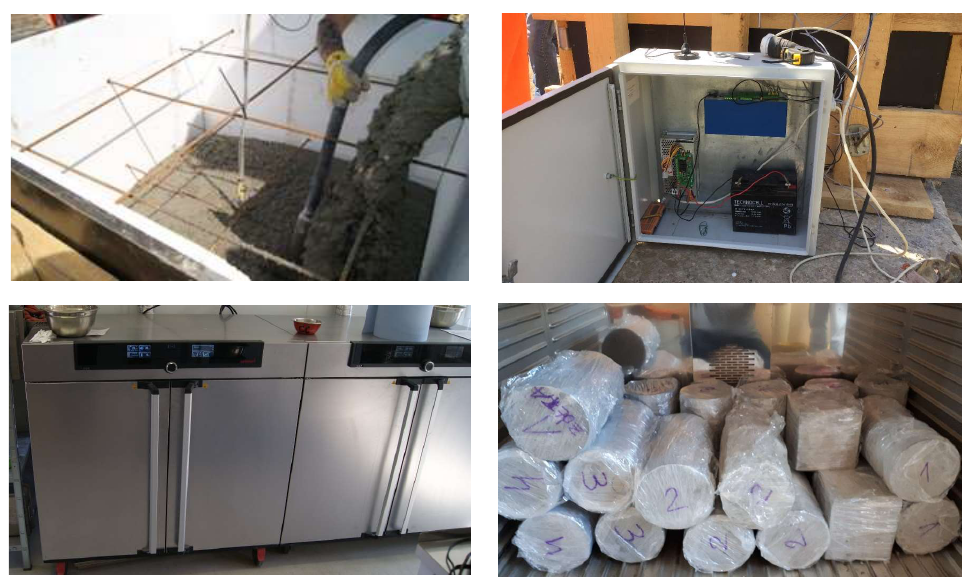
Figure 5. Elements of the system of structure conditions of concrete curing.